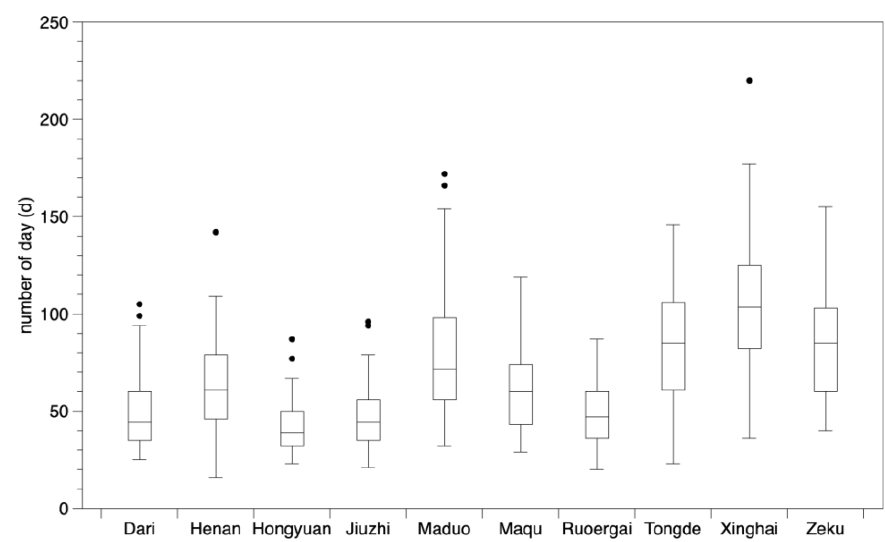
Figure 4. Boxplot of CDD at selected locations during the study period.